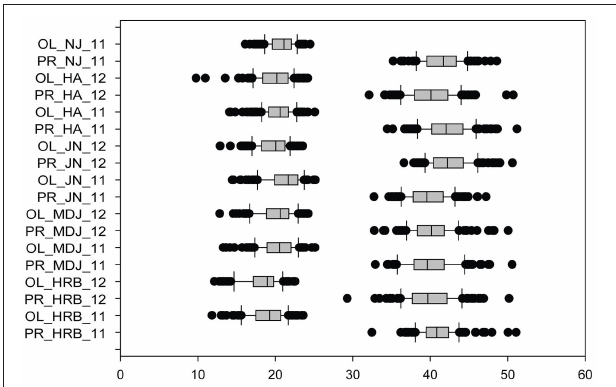
FIGURE 5 | Phenotypic variations in protein (PR) and oil (OL) contents of cultivars or accessions at different locations and in 2011 and 2012. The phenotypic segregation is shown in box-plot format. The interquartile region, median, and range are indicated by the box, the bold horizontal line, and the vertical line, respectively. For location, HRB, Harbin; MDJ, Mudanjiang; GZL, Gongzhuling; JN, Jinan; HA, Huaian; NJ, Nanjing. For years, 11, 2011; 12, 2012.